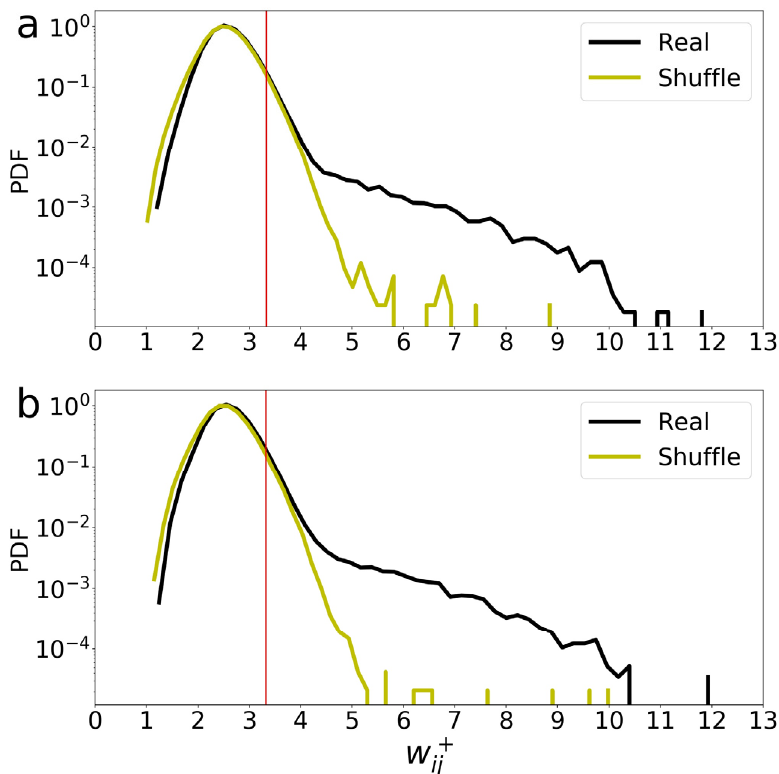
Figure 1. The W + probability density function (PDF) of two examples for ( a ) 1949 and ( b ) 1971. Red line represents the threshold value W c = 3.33 for 1949 and W c = 3.36 for 1971, the top 5% level of PDF for real data, which is also higher than the 95% confidence level of shuffled data.